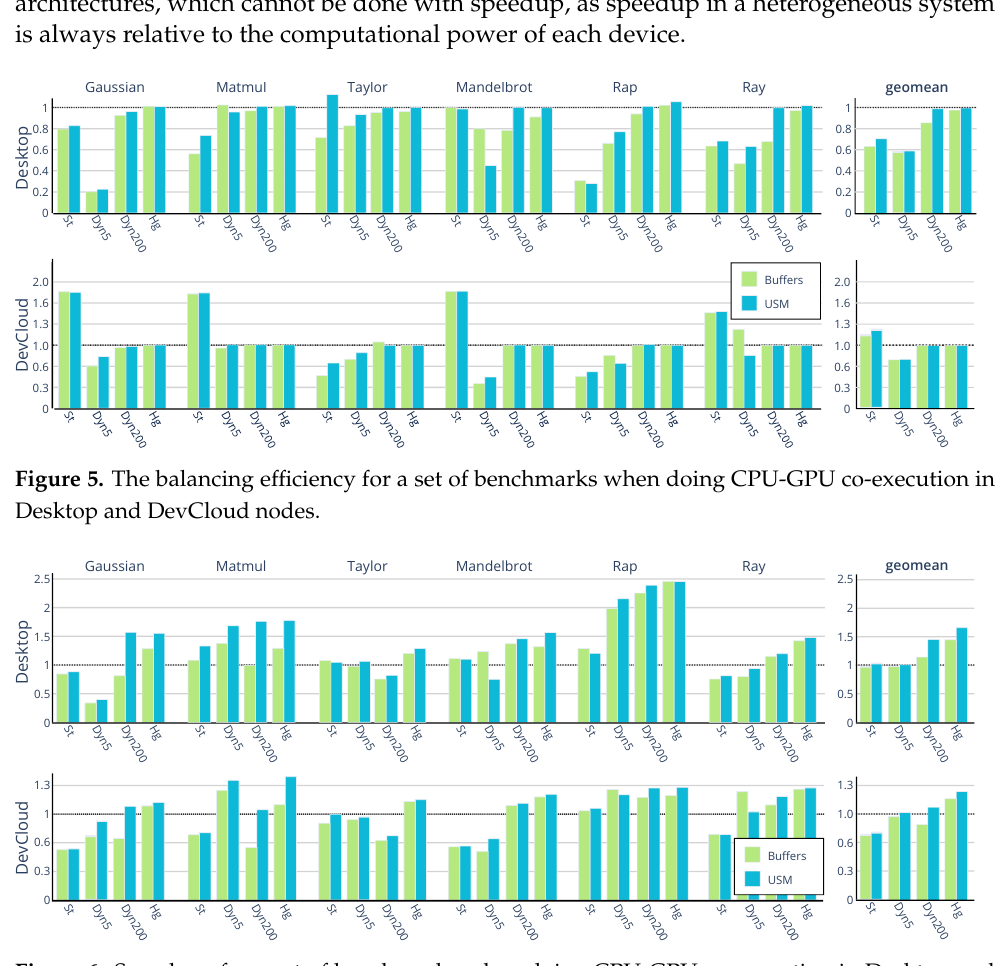
Figure 6. Speedups for a set of benchmarks when doing CPU-GPU co-execution in Desktop and DevCloud